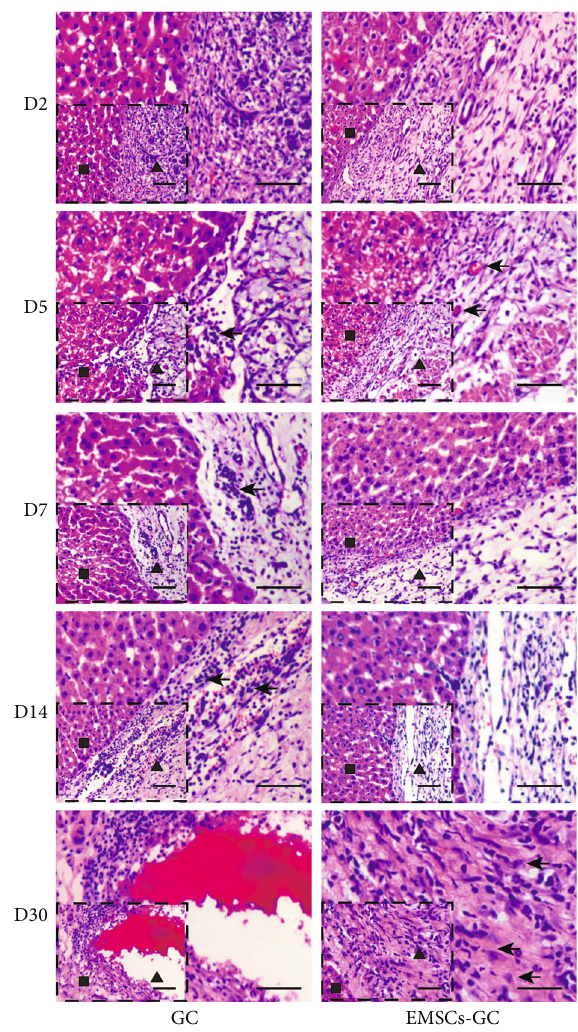
Figure 4: H&E staining of GC and EMSC-GC sca ff olds on the liver in vivo. Small insets depict an overview of the GC sca ff olds and liver tissues. The border between the GC sca ff olds and the liver parenchyma is represented by larger fi gures. Day 2: the borders of the GC matrices (the triangle) and the liver parenchyma (the square) were clear in the sections. Day 5: neovascularization was observed in the EMSC-GC groups (arrowhead). Day 7: the number of new blood vessels decreased, whereas the in fl ammatory cells markedly in fi ltrated the control group (arrowhead). Day 14: the neovascularized areas receded with limited in fl ammatory cell in fi ltration in the EMSC-GC group and a large amount of in fl ammatory cell in fi ltration in the control group. Month 1: in the EMSC-GC groups, some hepatocyte-like cells with large nuclei, abundant cytoplasm, and light color were observed at the edges of the sca ff old (arrowhead). Scale bar = 200 μ m